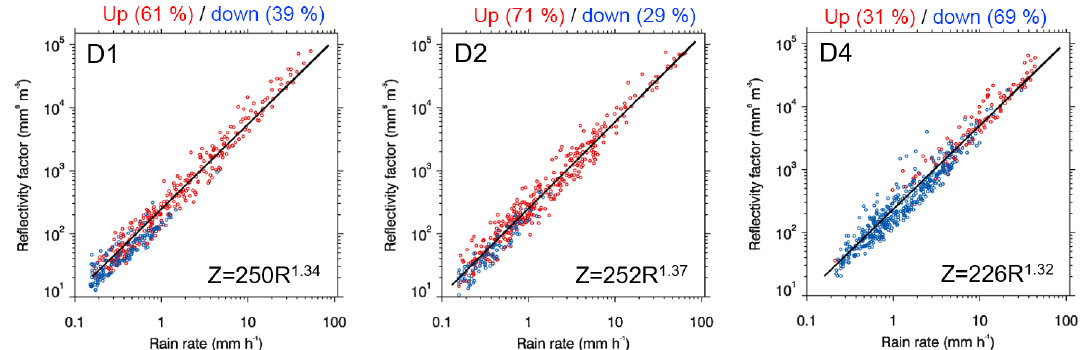
Figure 6. Z – R scatterplots at the three sites. Red dots indicate upward w and blue indicate downward w . Numbers on the top show percent- ages of frequency of occurrence in each w category.